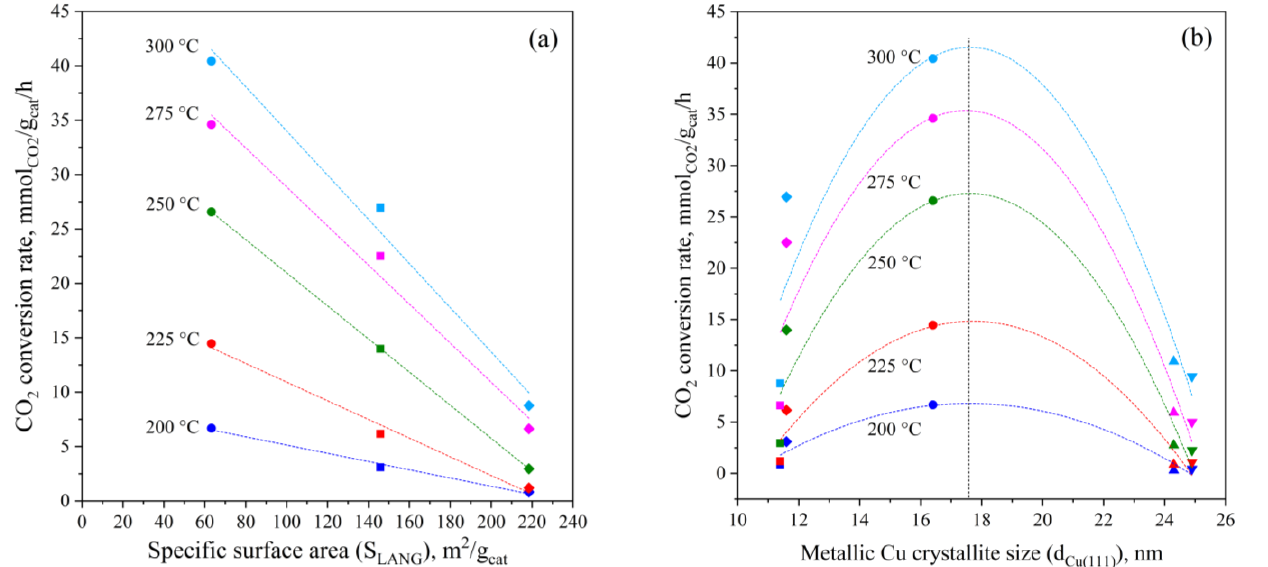
Figure 7. Relationships between the CO 2 conversion rate and ( a ) the specific surface area and ( b ) the average crystallite size of the metallic Cu of the spent samples. Reaction conditions: 2.5 MPa; inlet H 2 /CO 2 /N 2 , 3/1/1 mol/mol; WHSV, 20 N L∙g CuZnZr −1 ∙h −1 (● CuZnZr; ♦ CZZ/FER OX 2:1; ■ CZZ/FER inlet H 2 /CO 2 /N 2 , 3/1/1 mol/mol; WHSV, 20 NL · g CuZnZr − 1 · h − 1 ( • CuZnZr; (cid:7) CZZ/FER OX 2:1; OX 1:2; ▲ CZZ/FER WI 1:2; ▼ CZZ-FER MIX 1:2). (cid:4) CZZ/FER OX 1:2; (cid:78) CZZ/FER WI 1:2; (cid:72) CZZ-FER MIX